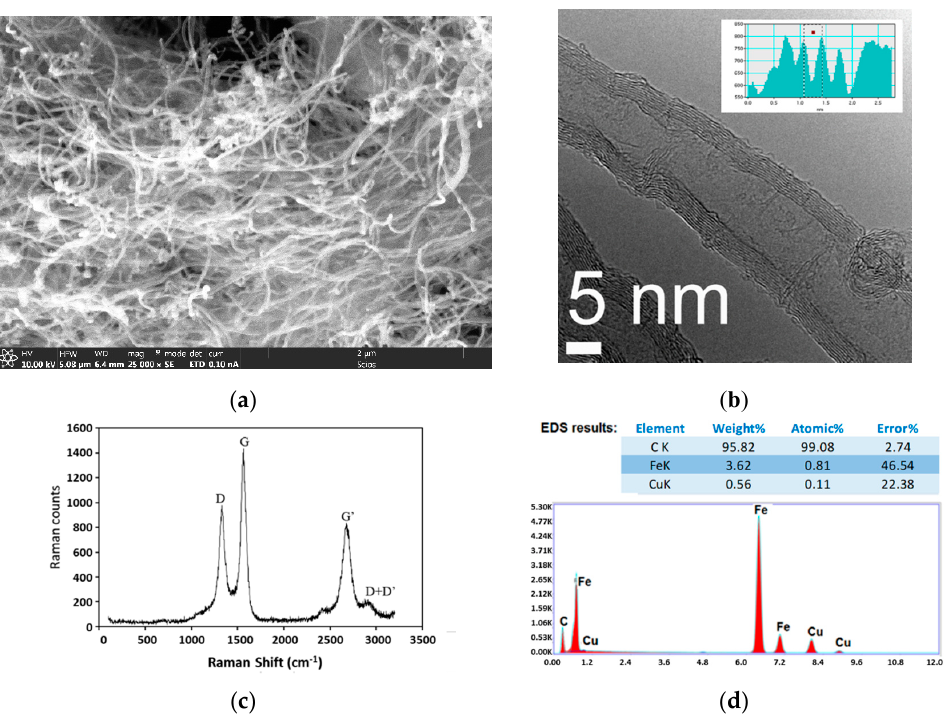
Figure 6. Characterizations of MWCNTs formed from the CO/CH 4 mixture: ( a ) SEM image, ( b ) TEM image showing typical MWCNT diameter and wall thickness, ( c ) Raman shift spectrum of the MWCNTs, and ( d ) EDS measurement focusing on MWCNT tips (insert survey over a large sample area).